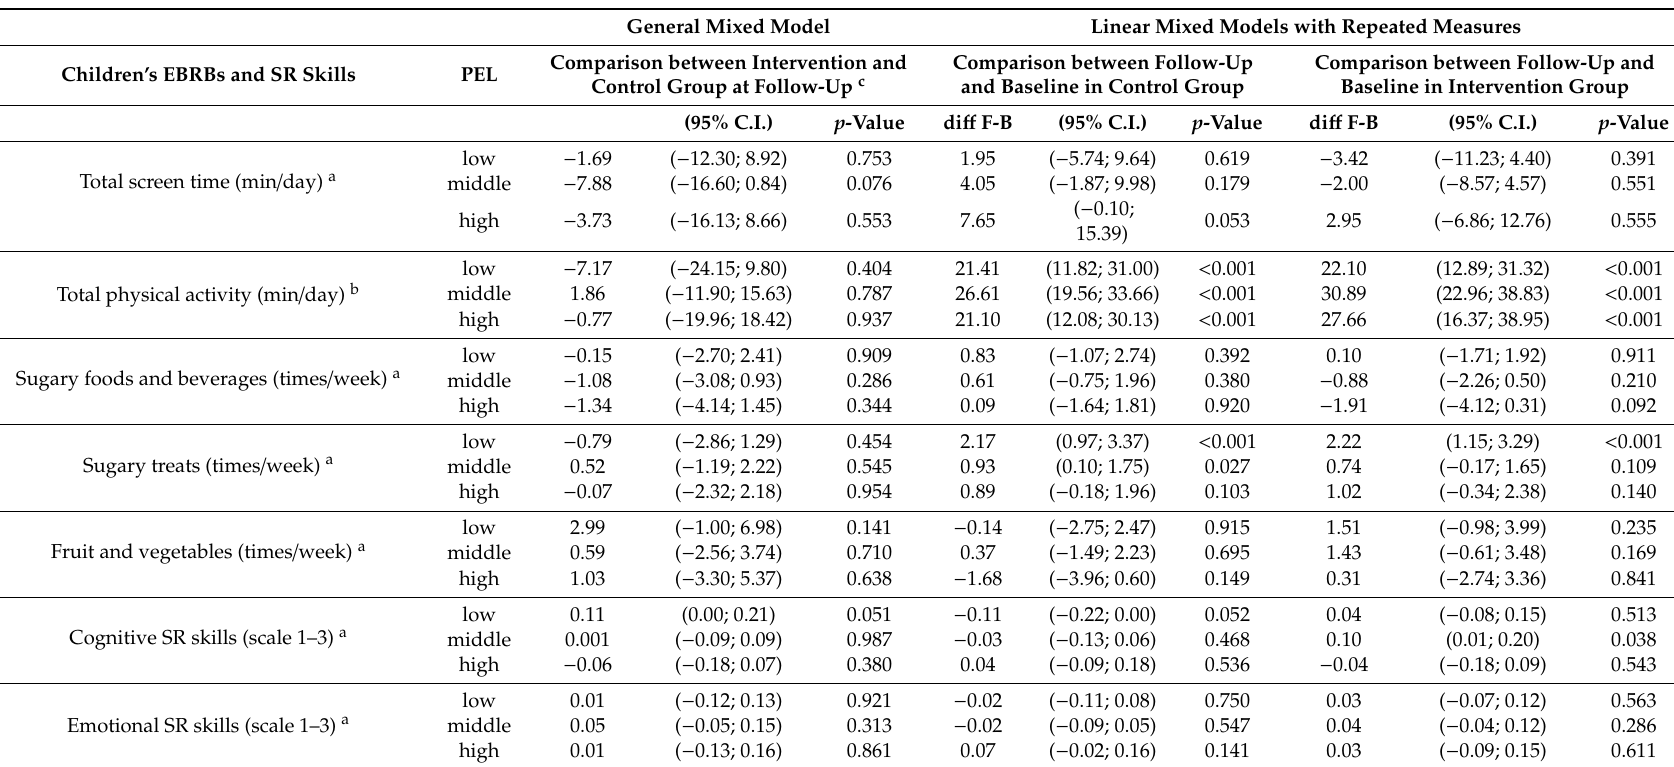
Table 4. Comparison between the intervention and control group by parental educational level and changes within groups